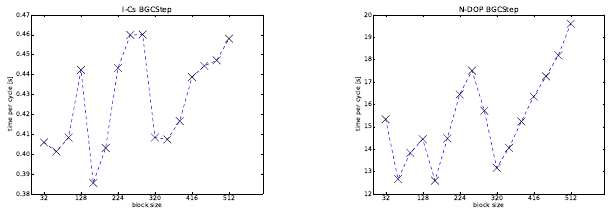
Fig.3. ComputationaltimeneededfortheI-Cs(left)andN-DOP(right)modelwithinonemodelyeardependingontheblocksize. Fig. 3. Computational time needed for the I-Cs (left) and N-DOP